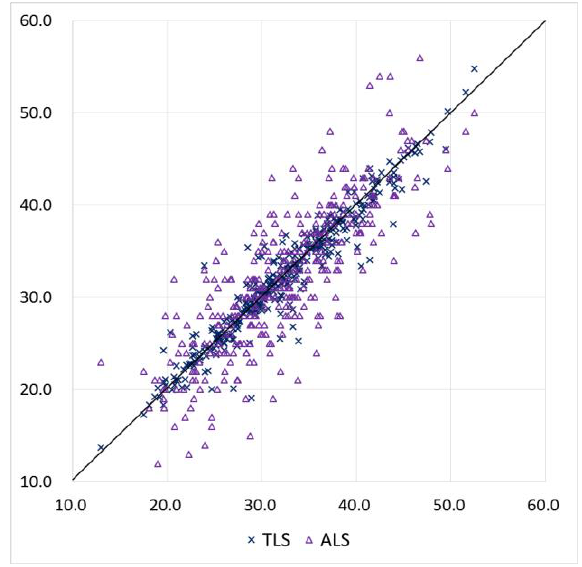
Figure 3. DBH comparison of TLS and ALS for individual tree